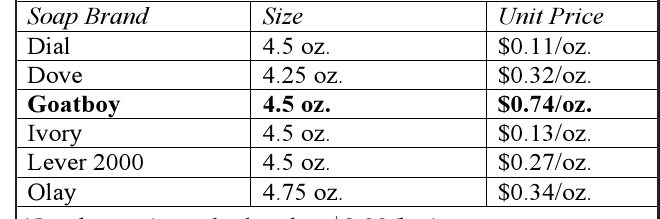
(Goatboy price calculated at